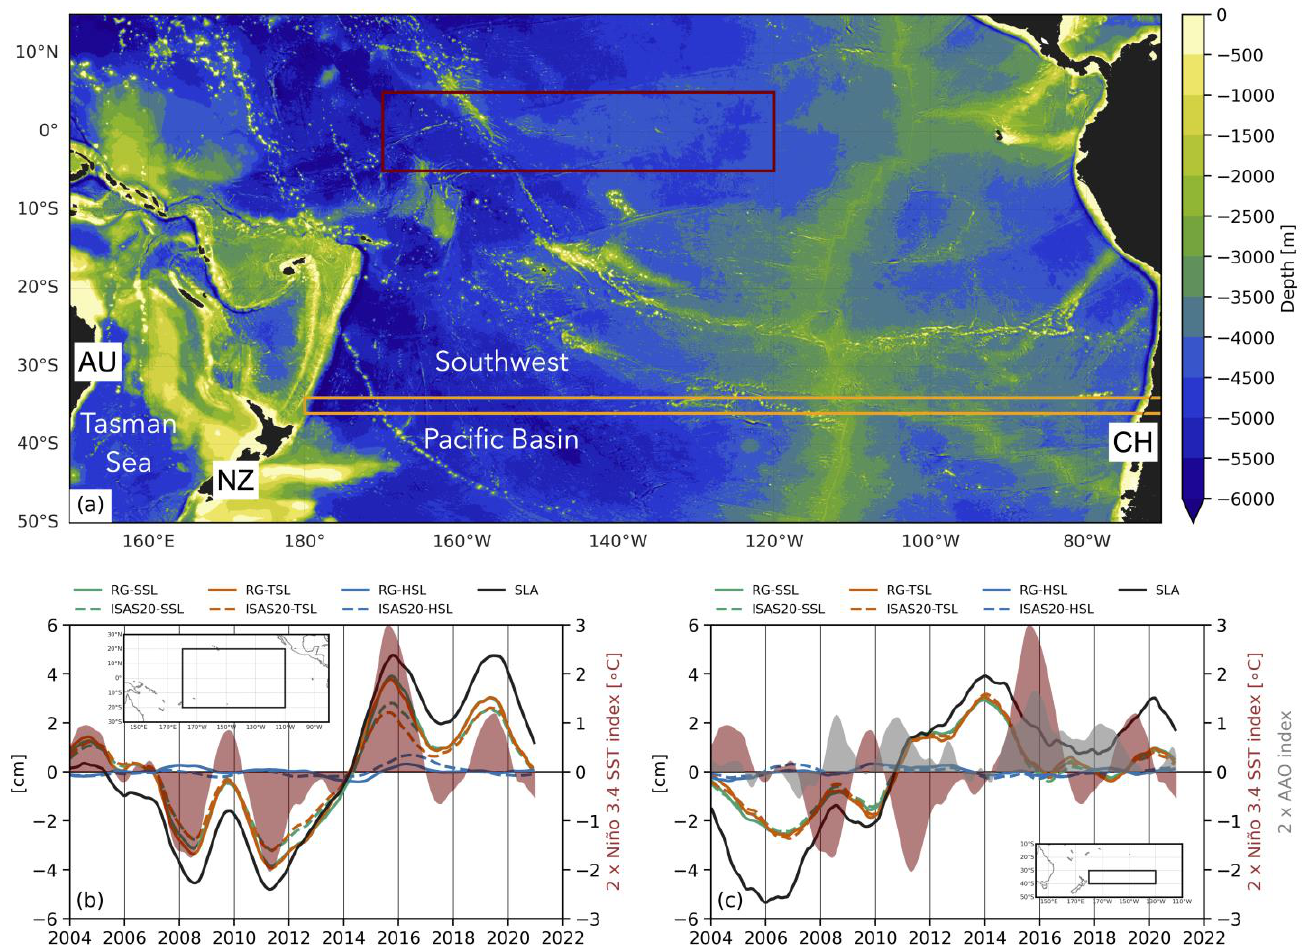
Figure 1. ( a ) Bathymetry map derived from the gridded 15 arc-second General Bathymetric Chart of the Oceans (GEBCO) 2022. Country names are indicated on the map as follows: Australia (AU); New Zealand (NZ) and Chile (CH). The dark red rectangle shows the Niño 3.4 SST index region, while the orange rectangle shows the region of the reduced-gravity model used in this study. ( b , c ) Interannual sea level budget with altimetry sea level anomaly (SLA; black) and 0 – 2000 dbar Argo steric contributions during 2004 – 2020 and averaged over ( a ) 20°S – 20°N, 180° – 110°W and ( b ) 30°S – 40°S, 180° – 130°W (black rectangles in the insets for geographic location). In ( a , b ), time series of SLA (black), steric sea level (SSL; green), thermosteric sea level (TSL; orange) and halosteric sea level (HSL; blue) are shown. Argo contributions derived from the Roemmich-Gilson (RG) Climatology and the 8th version of the In Situ Analysis System (ISAS20) are, respectively, in solid and dashed lines. Red and gray shadings represent the Niño 3.4 sea surface temperature (SST) index and the AAO index, respectively, with a 1.5 year running mean applied and scaled by 2 for plotting pur- poses.